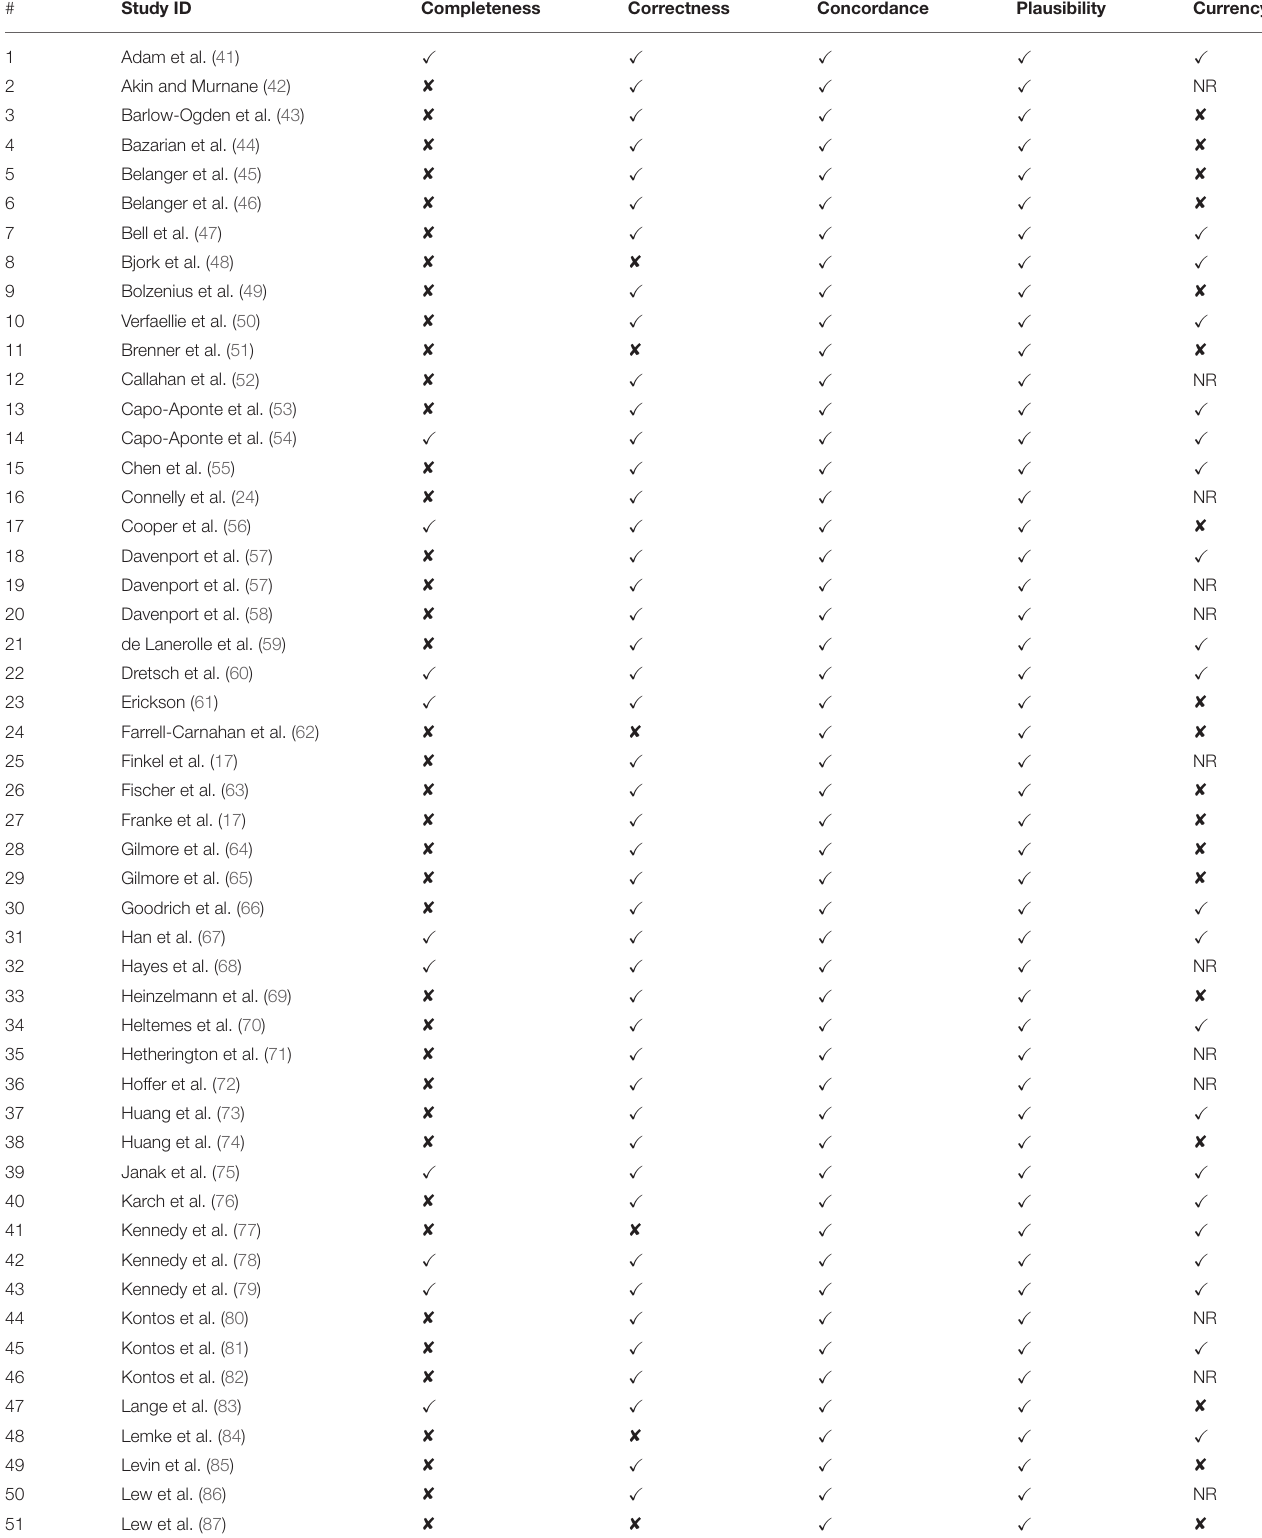
TABLE 3 | Quality assessment of included